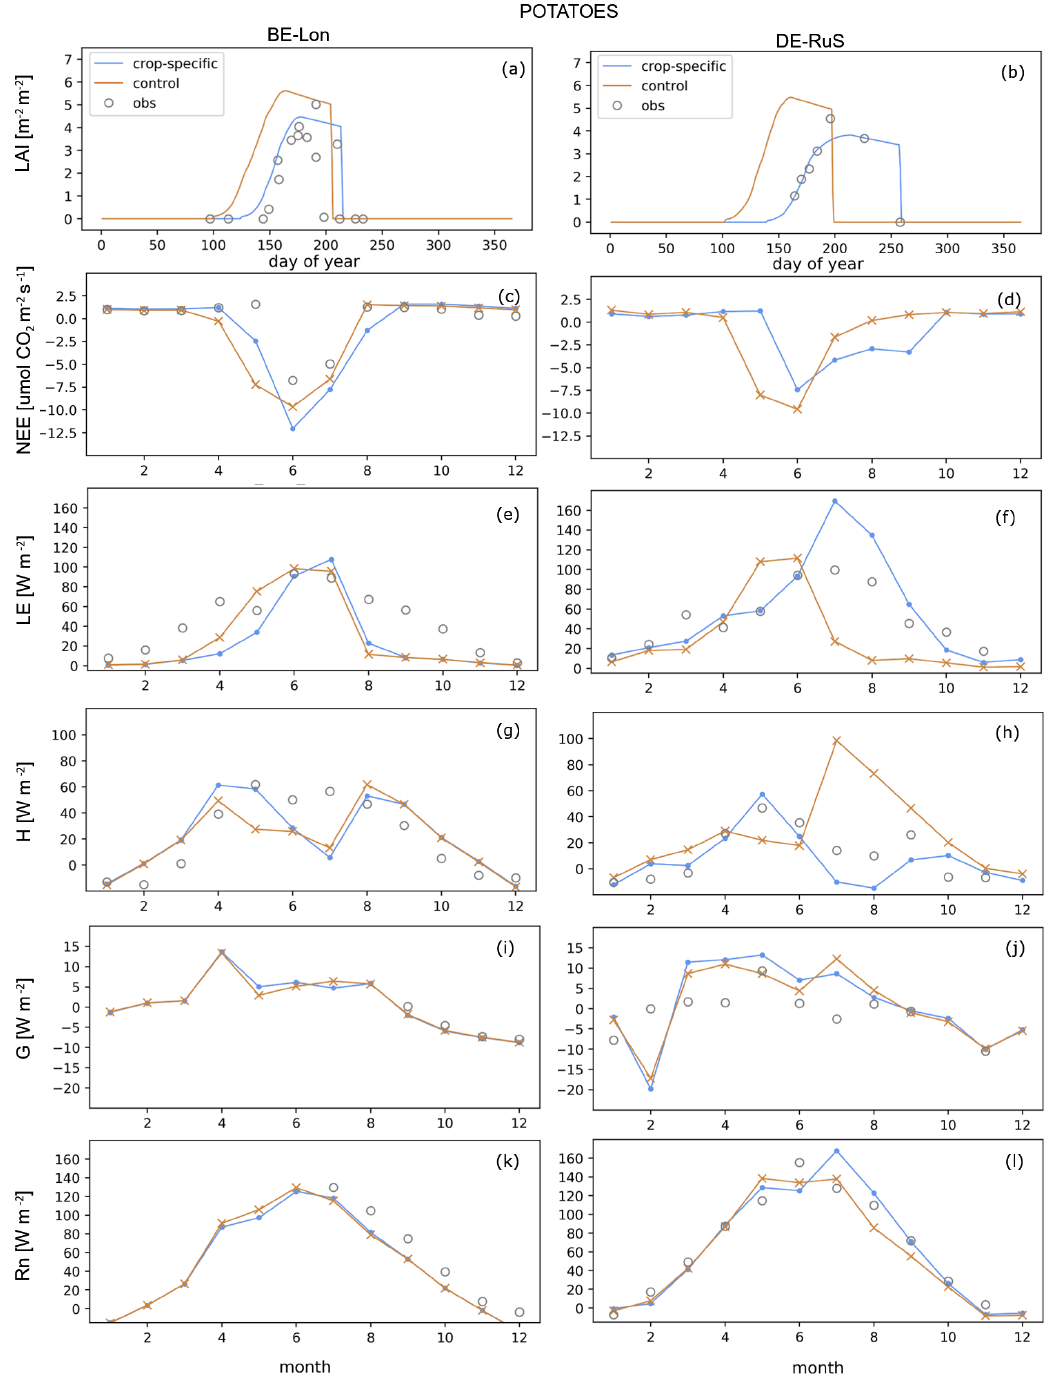
Figure 6. Simulation results of (a–b) LAI and monthly averaged simulation results of (c–d) NEE, (e–f) LE, (g–h) H , (i–j) G , and (k–l) Rn for all potato years (see Table 5) at the sites (left) BE-Lon and (right) DE-RuS. Simulation results for the control run (orange) and the crop-specific parameter set (blue) are compared to available site observations (grey) of LAI (all available observations plotted) and fluxes (averaged over all respective years). Corresponding performance statistics for daily simulation results are listed in Table